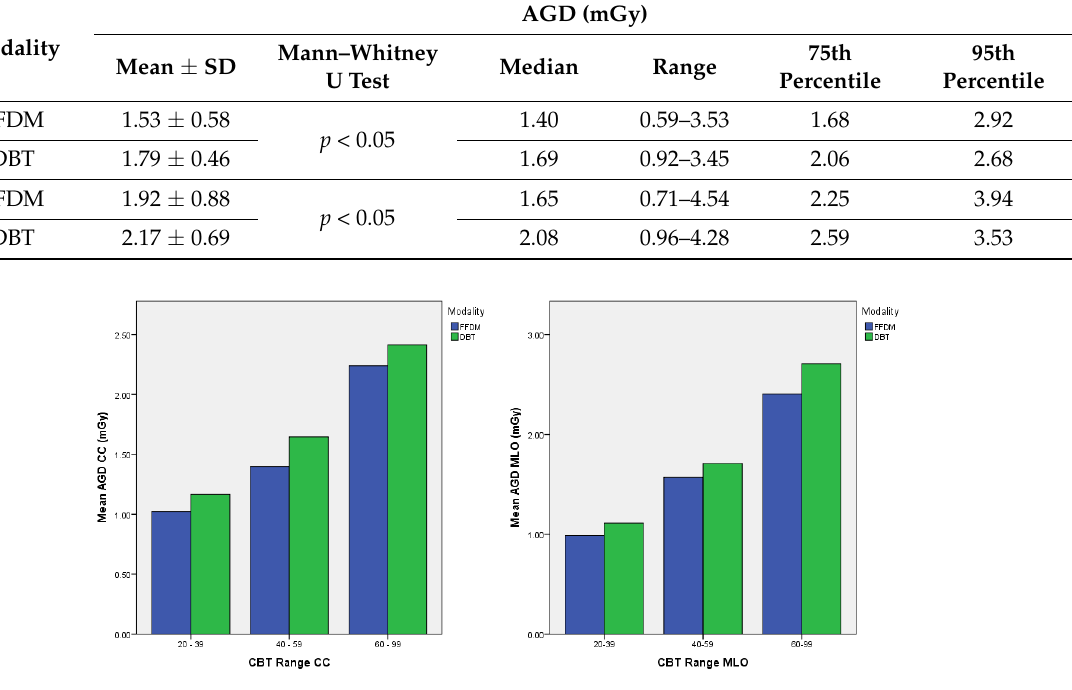
Figure 1. Histogram of AGD of full-field digital mammography (FFDM) and digital breast tomo- synthesis (DBT) across different CBT ranges for CC and MLO projections. Table 6. The mean, median, 75th percentile, and 95th percentile of AGD per woman for each mam- mographic technique in different CBT groups.